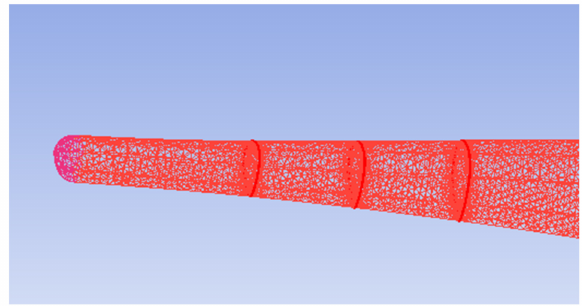
Figure 13. Meshing result of the tip section of the